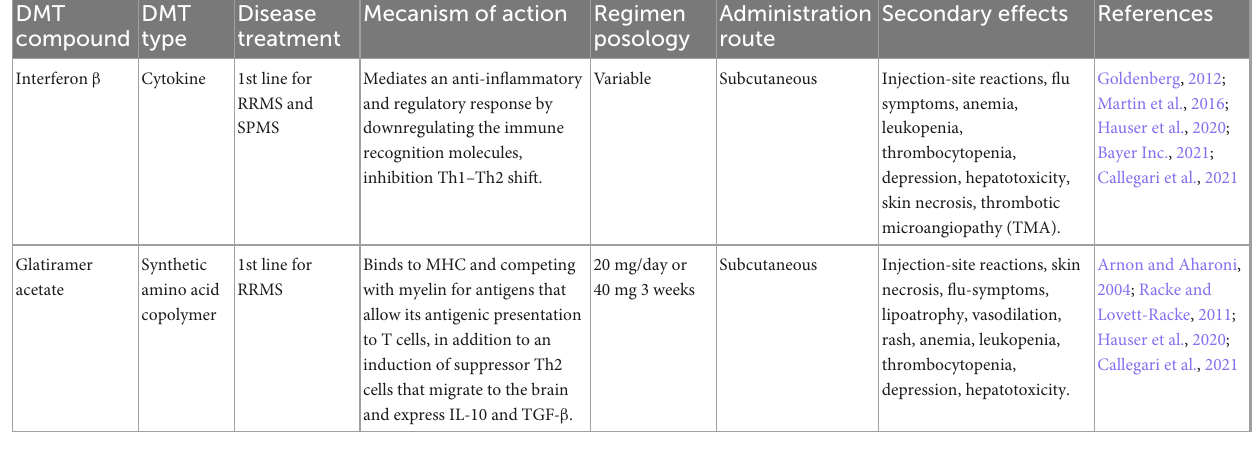
TABLE 2 Monoclonal